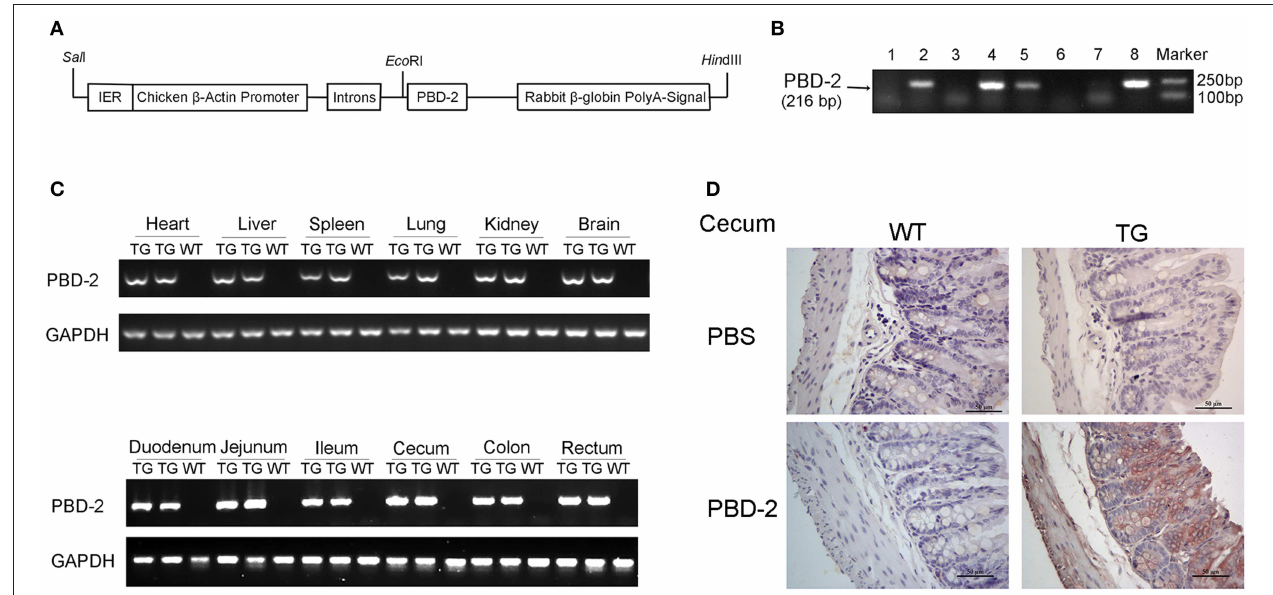
FIGURE 1 | Physiological characterization of PBD-2 TG mice. (A) PBD-2 expression box used to generate PBD-2-expressing TG mice. (B) PCR detection of TG mice. (C) Detection of the expression of PBD-2 in the organs of TG mice by qRT-PCR. (D) Detection of the expression of PBD-2 in caecum by immune histochemical analysis. The locations with brown colors show positive signals that indicate PBD-2